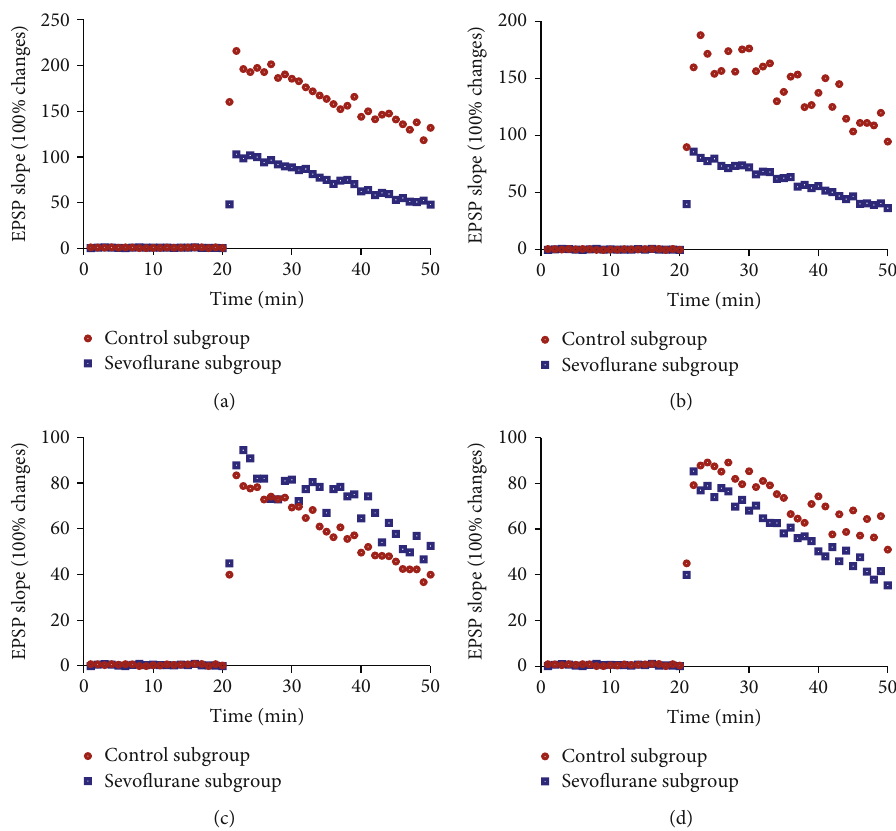
Figure 5: Time-course of long-term potentiation (LTP) of hippocampal slices. The responses were recorded in hippocampal tissue to test stimuli delivered to the perforant path or Scha ff er commissural fi bers. Tetanic stimulation was performed at 20 min. According to the di ff erent time points of the behavioral experiment test, the mice were stopped for the inhalation of sevo fl urane or oxygen after 12 h (T1) (a), 24h (T2) (b), 48h (T3) (c), and 72 h (T4)